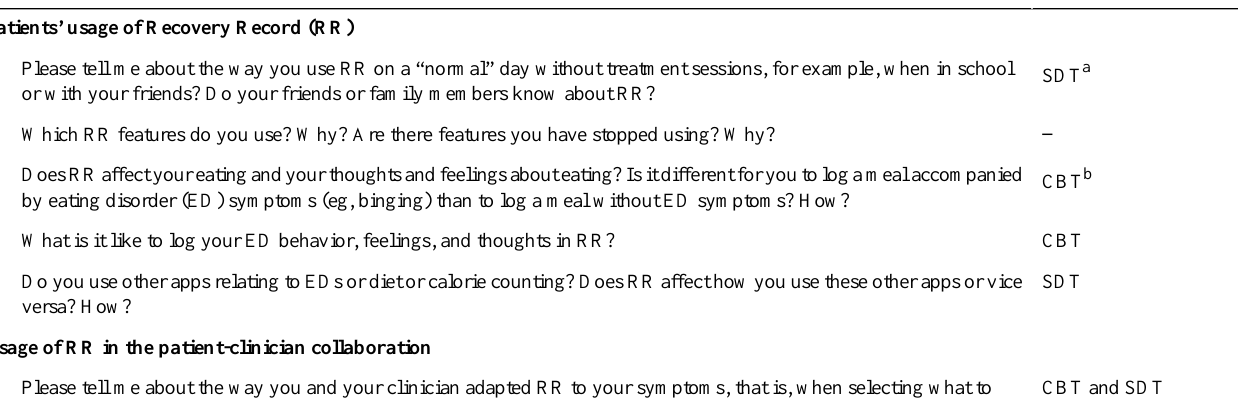
Table 1. Semistructured interview guide. The guide was adjusted to fit the number of interview participants, who were asked additional follow-up questions as needed, and the order of subjects (in bold) was flexible. The theoretical inspiration column identifies which part of the theoretical framework the questions were inspired by. Patients’usage of Recovery Record